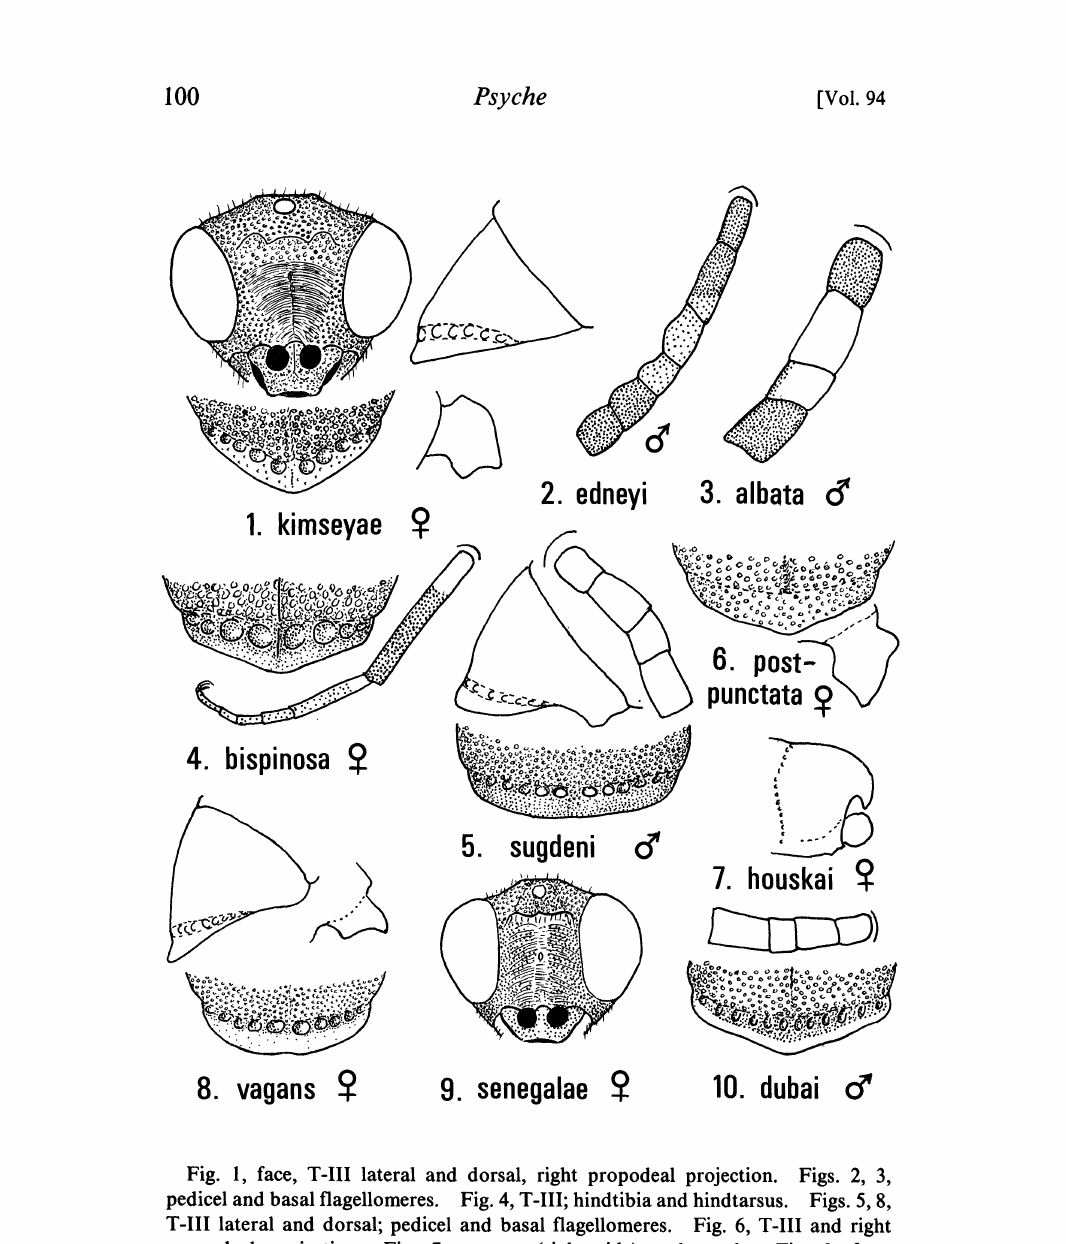
Fig. 1, face, T-Ill lateral and dorsal, right propodeal projection. Figs. 2, 3, pedicel and basal flagellomeres. Fig. 4, T-Ill; hindtibia and hindtarsus. Figs. 5, 8, T-Ill lateral and dorsal; pedicel and basal flagellomeres. Fig. 6, T-Ill and right propodeal projection. Fig. 7, scutum (right side) and tegula. Fig. 9, face. Fig. 10, pedicel and basal flagellomeres; T-Ill